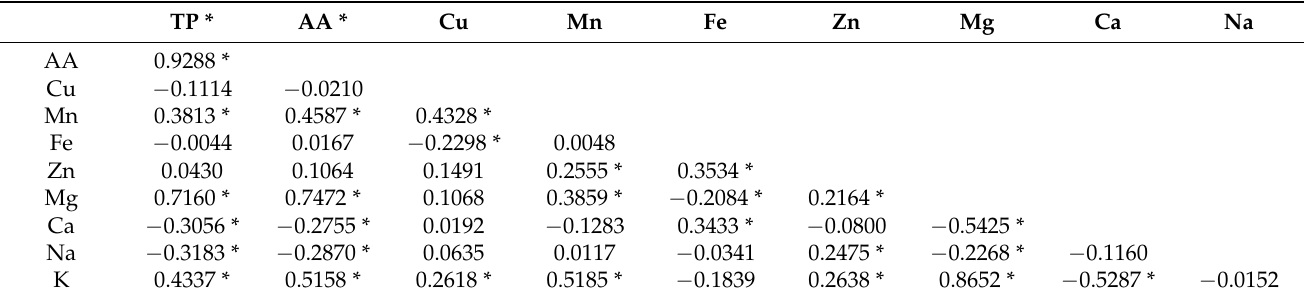
Table 3. Correlations between analysed